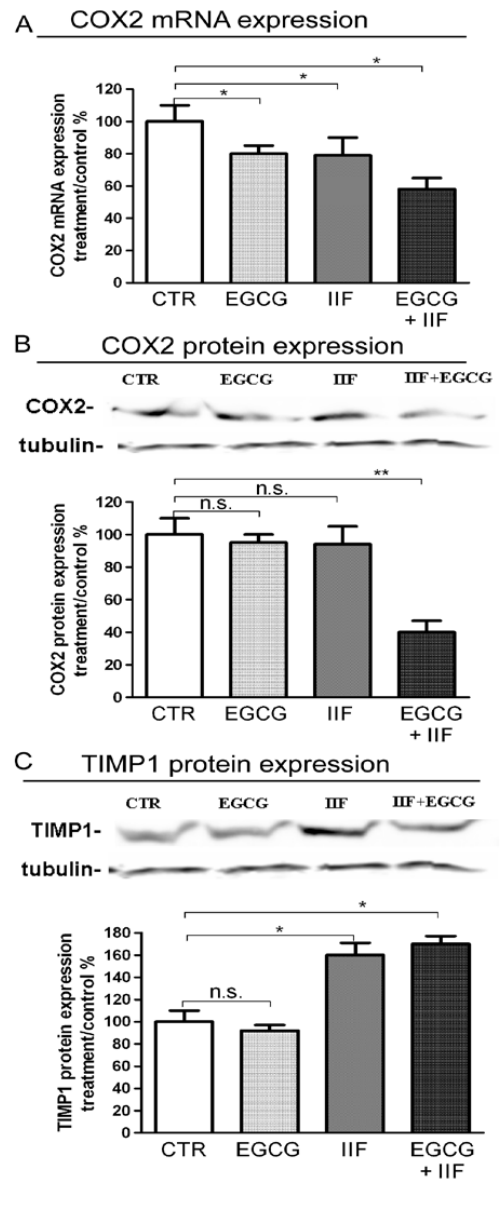
Figure 8. COX-2 and TIMP-1 expression after EGCG and IIF treatments in BE(2)-C neuroblastoma cells. ( A ) Cells were treated with 20 μg/mL EGCG and 10 μM IIF, individually and in combination for 24 h. ( A ) qPCR of COX-2 expression was performed after RNA isolation. GAPDH was used as an internal control. Western blot analysis of COX-2 ( B ) and TIMP-1 ( C ). The values were normalized to the untreated controls. β -tubulin was used as a loading control. The results are expressed as the average ± SE of three independent experiments. * p < 0.05; ** p < 0.01. n.s.: not